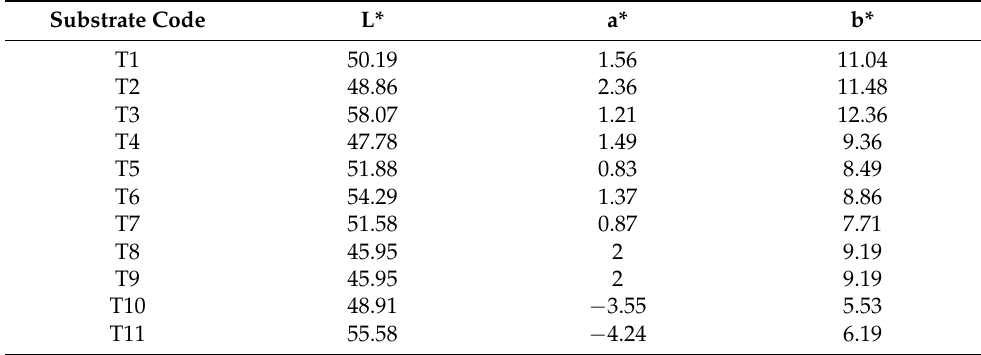
Table 10. CIELAB* coordinates (D 65 /10 ◦